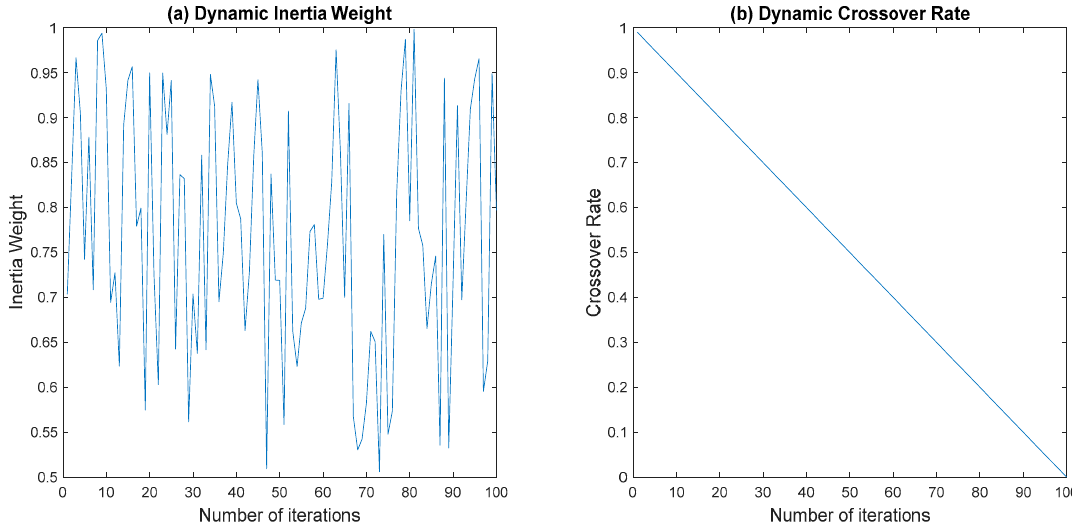
Figure 3. Samples of two schemes: ( a ) dynamic inertia weight and ( b ) dynamic crossover rate.